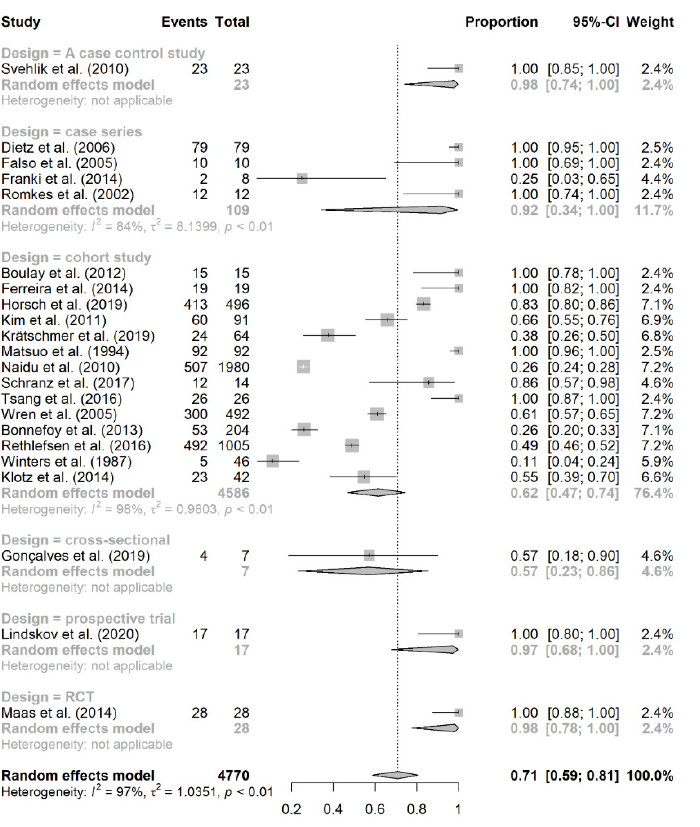
Figure 4. Subgroup analysis of equinus foot prevalence based on study design.